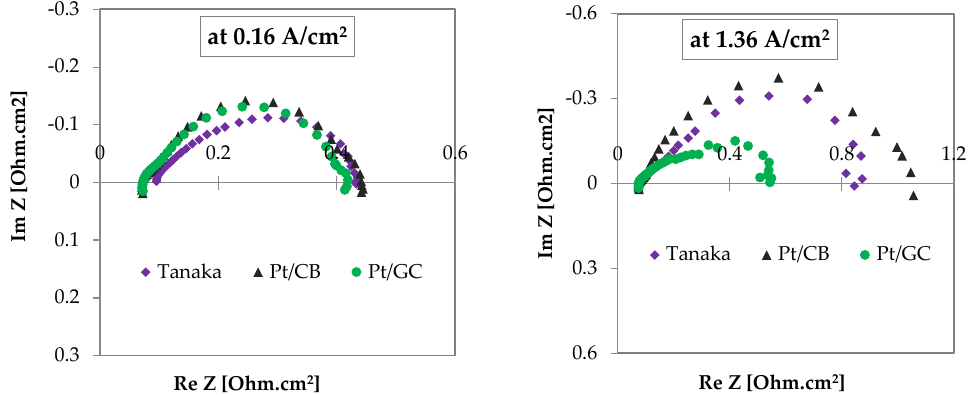
Figure 7. Nyquist plots at 0.16 and 1.36 A/cm 2 current densities of the MEAs with Pt/CB, Pt/GC, and Tanaka catalysts under the same operation conditions as performance tests.